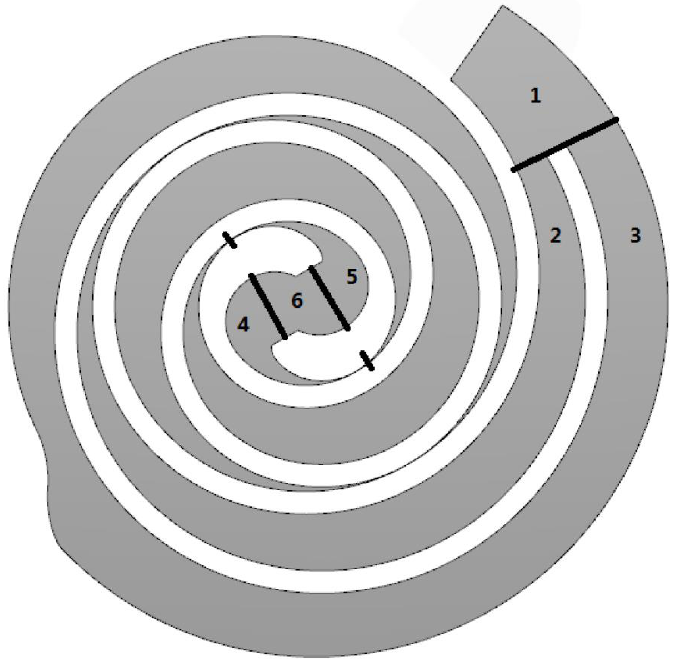
Figure 3. Rotor meshing strategy in PumpLinx: Rotor domain partitions [48].